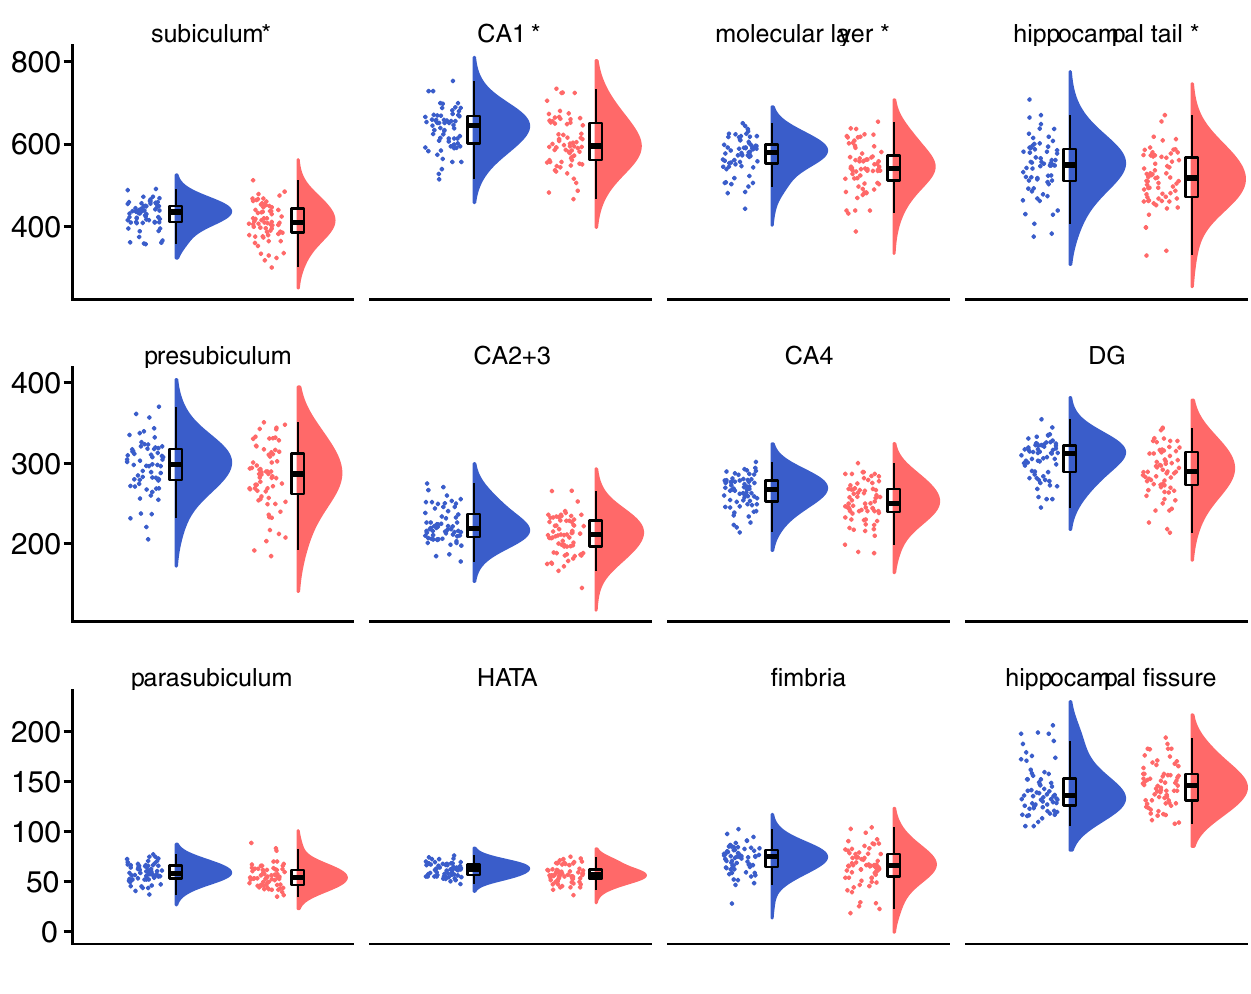
Fig 2. Regional volumes adjusted for estimated total intracranial volume (eTIV). Half violin raincloud plots [52] show hippocampal subfield volumes for the NC and AUD groups. See S1 Table for mean and standard deviation values. Abbreviations: CA1 = cornu ammonis 1; CA2+3 = cornu ammonis 2 and 3; CA4 = cornu ammonis 4; DG = dentate gyrus; HATA = hippocampal-amygdaloid transition area; Sub = subiculum; NC = Nonalcoholic Control group; AUD = Group with history of Alcohol Use Disorder. � Indicates regions where AUD < NC, p < 0.0042.